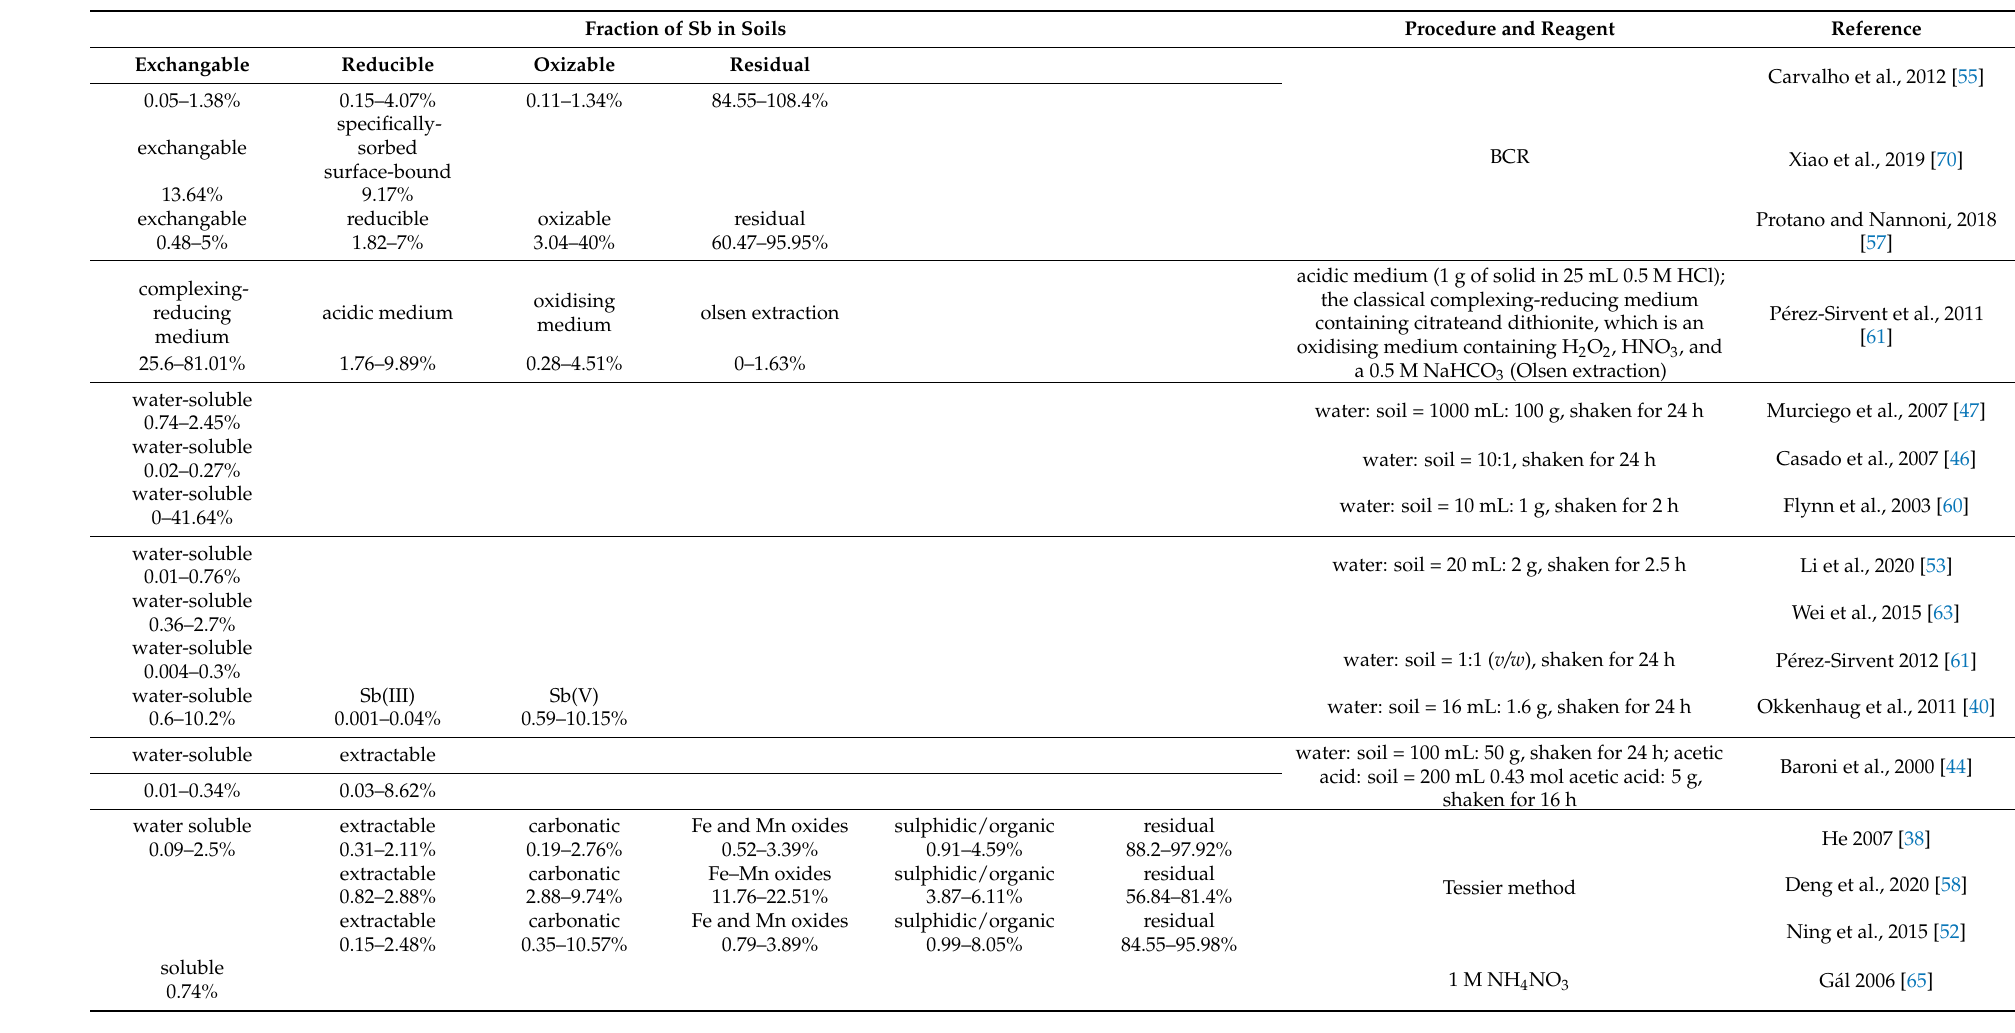
Table 1. Summary of Sb speciation in soils related to mining/smelting